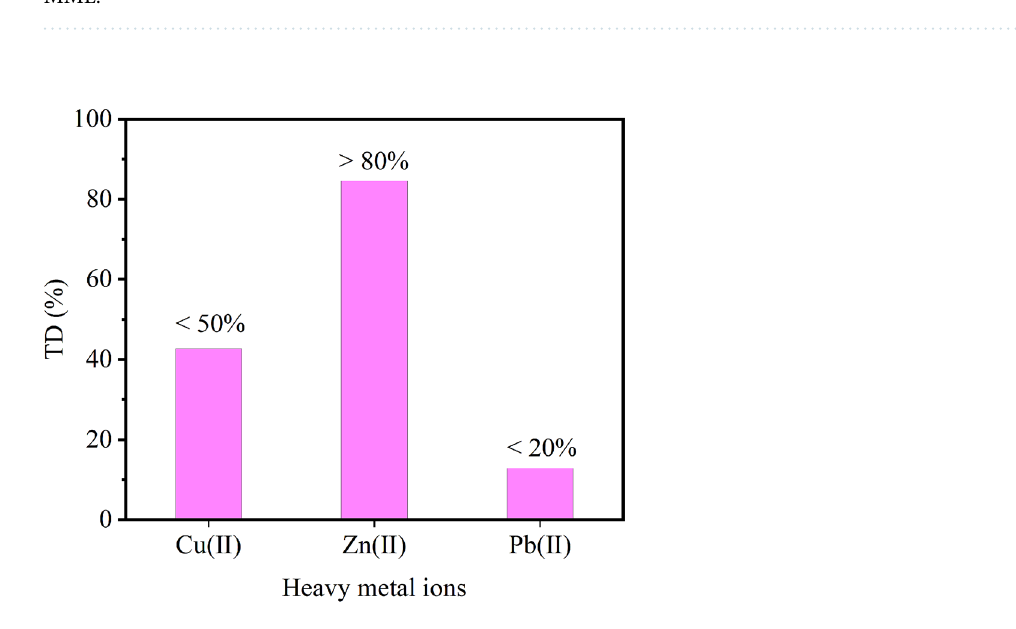
Table 3. Thermodynamic parameters for adsorption of Cu 2+ , Zn 2+ and Pb 2+ onto different samples: Lignite; MML.